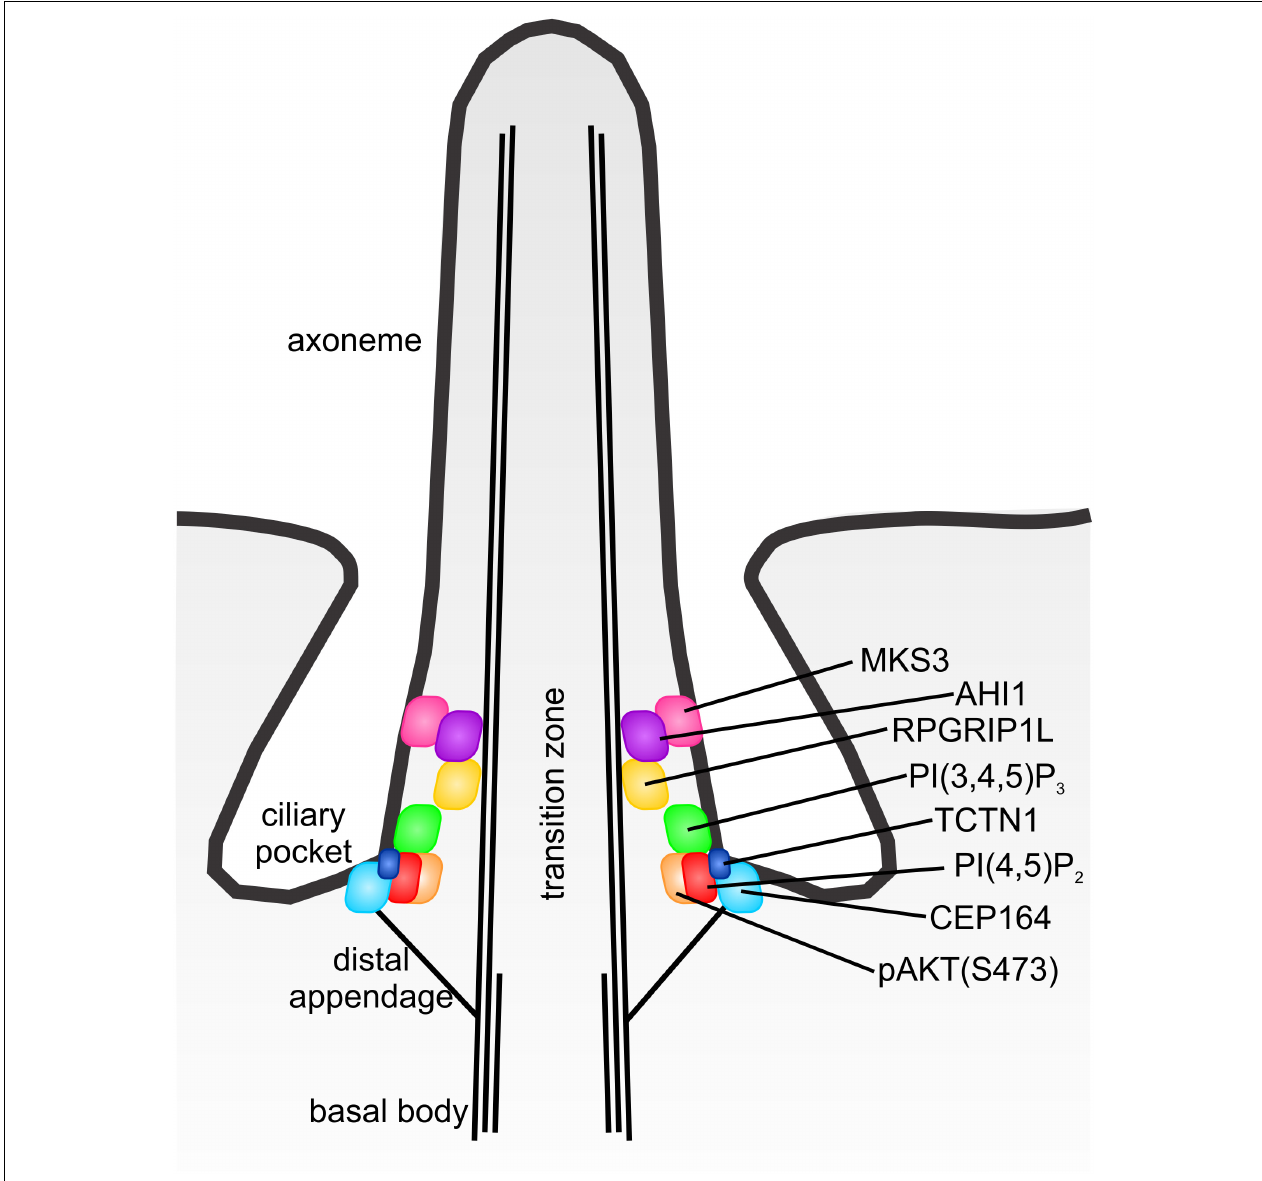
FIGURE 9 | Model of transition zone phosphoinositide localization. Model depicting the superresolution localization of PI(4,5)P 2 , PI(3,4,5)P 3 and pAKT(S473) in the context of the transition zone protein and distal appendage